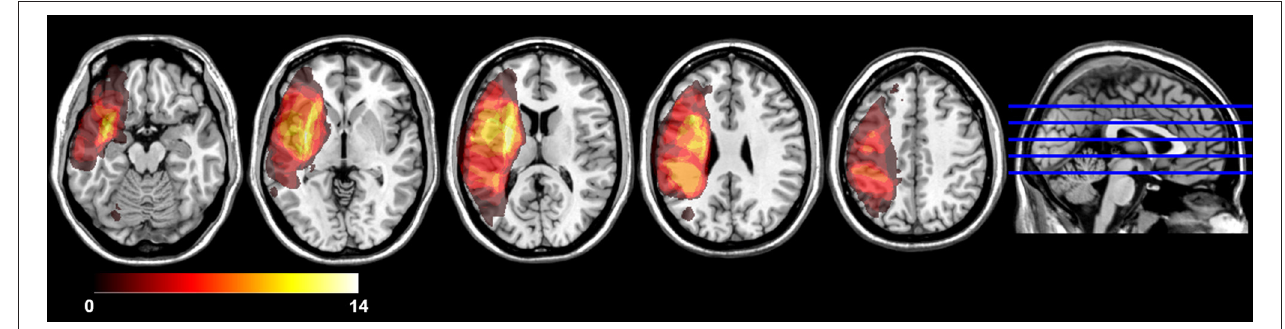
FIGURE 1 | Lesion overlap map ( n = 14) (1 missing data). All lesions were in LH MCA territory. Lesion overlap was greatest in subcortical white matter in striatocapsular region.